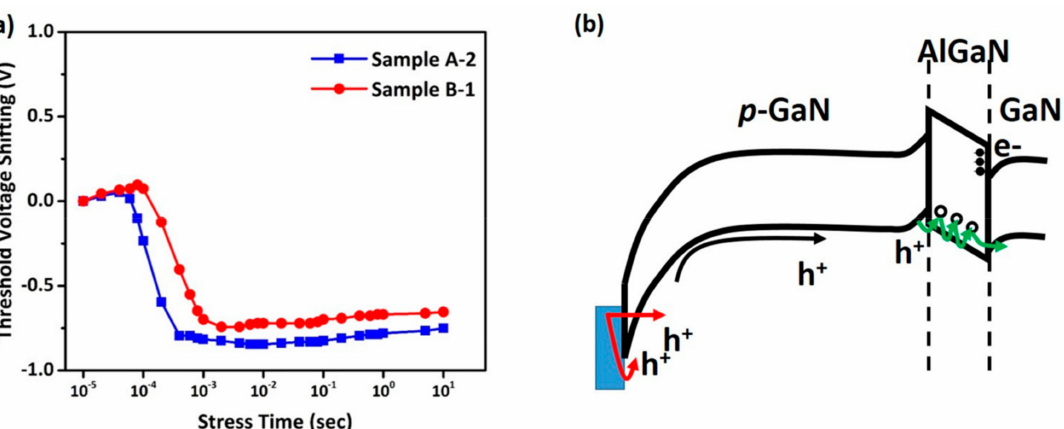
Figure 6. ( a ) Experimental threshold voltage shifting versus accumulated stress time for Sample A-2 and Sample B-1. ( b ) The energy band diagram of the Schottky metal/p-GaN/AlGaN/GaN gate stack at V G = 6 V with different threshold voltage shifting mechanisms. The red arrow indicates the holes across the Schottky barrier height, the green arrow shows the out-diffusion of Mg as an acceptor-like trap level in